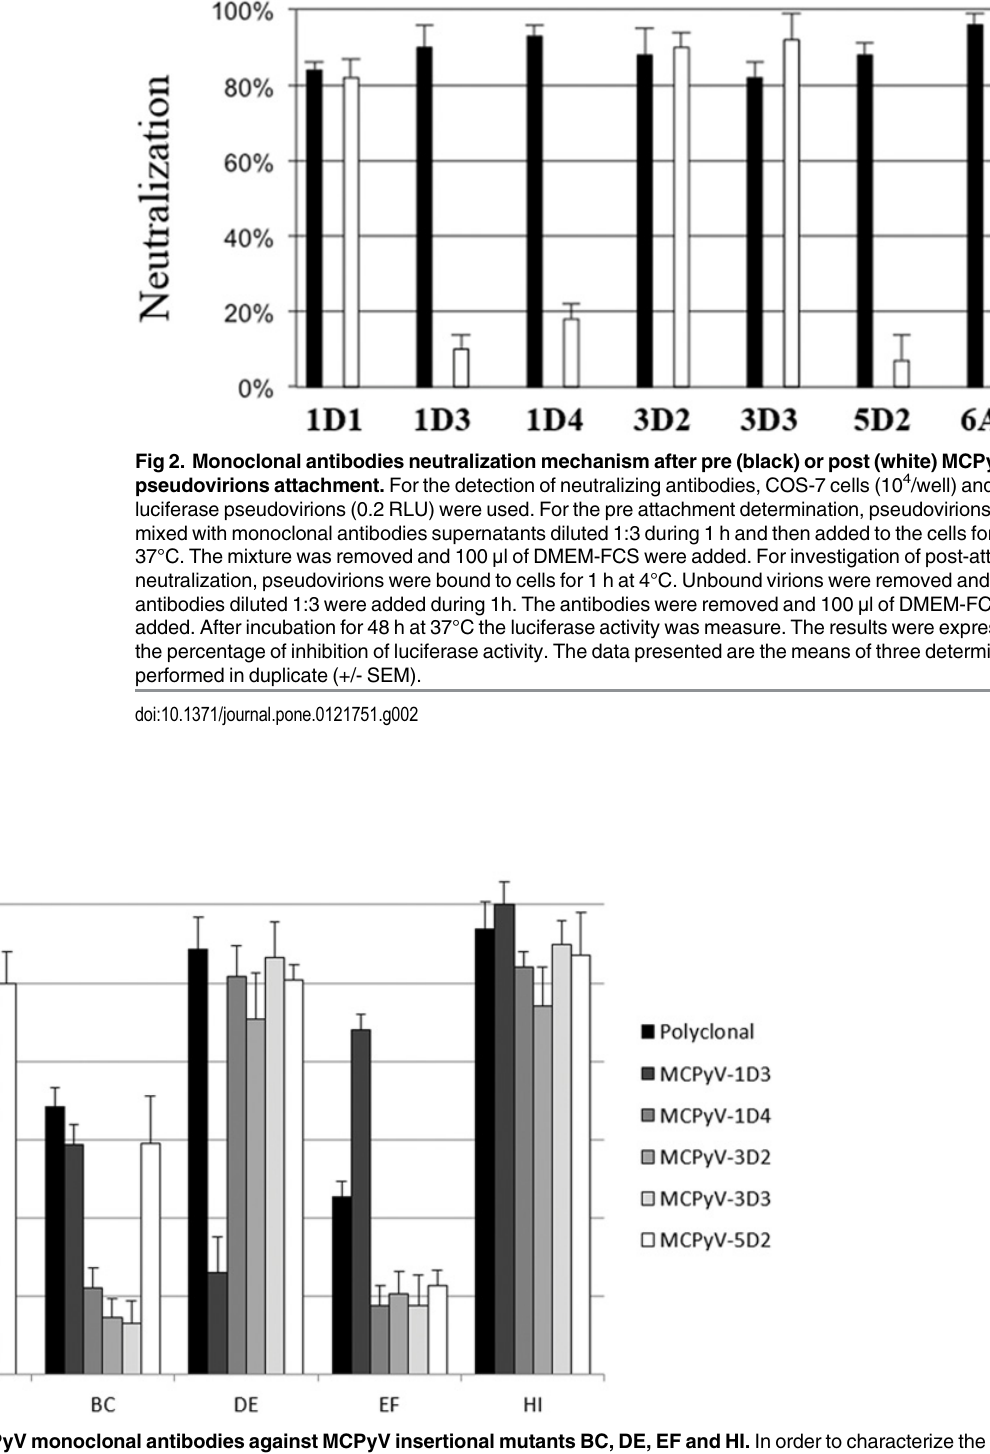
Fig 3. ELISA reactivity of MCPyV monoclonal antibodies against MCPyV insertional mutants BC, DE, EF and HI. In order to characterize the epitopes of the MCPyV VP1, the reactivity of mAbs was analyzed using the MCPyV wt VP1 VLPs and the four mutants with insertion within the BC, DE, EF and HI VP1 loops. ELISAs were performed using hybridoma culture supernatants diluted 1:3. The results are presented as relative binding defined as the reactivity of mAb to mutant VLPs divided by the reactivity of the same mAb observed with wild-type VLPs. The data presented are the means of three determinations (+/-